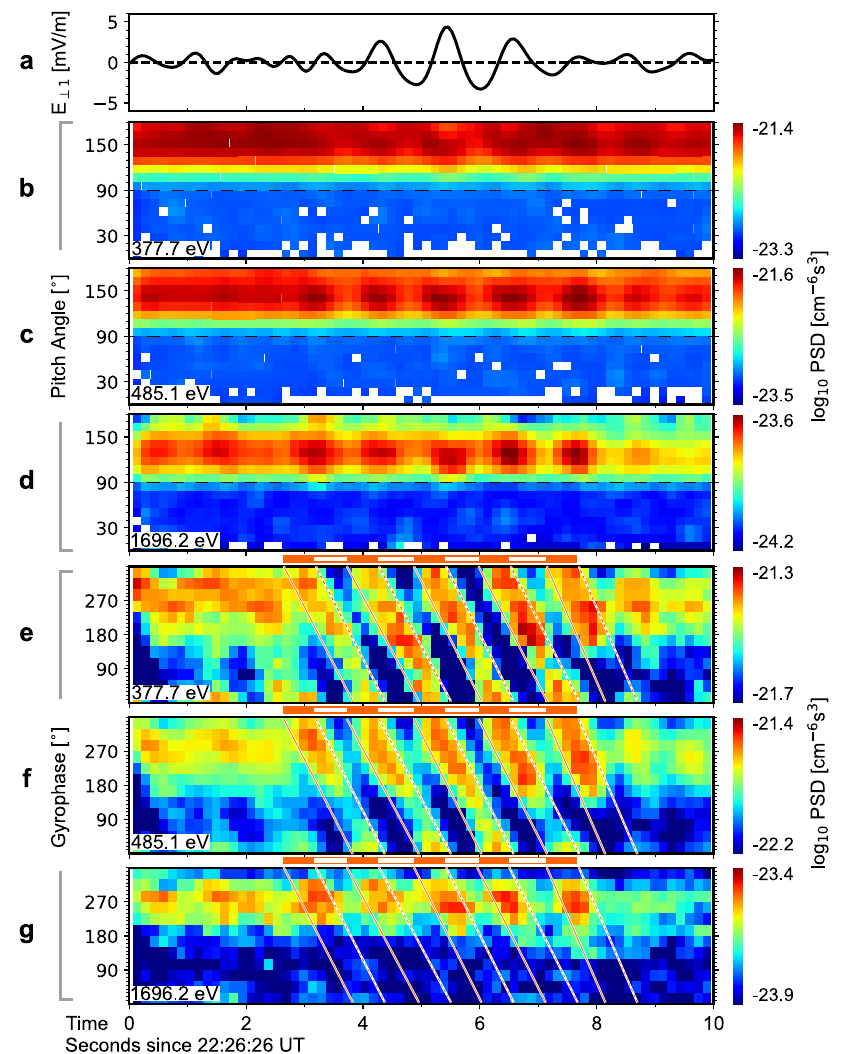
Fig. 3 | Detailed observations of proton dynamics induced by KAWs. a A per- pendicularcomponentoftheKAWelectric fi elds. b – d Thepitchangledistributions of protons. Gyrophase-averaged phase space densities are shown. e – g The